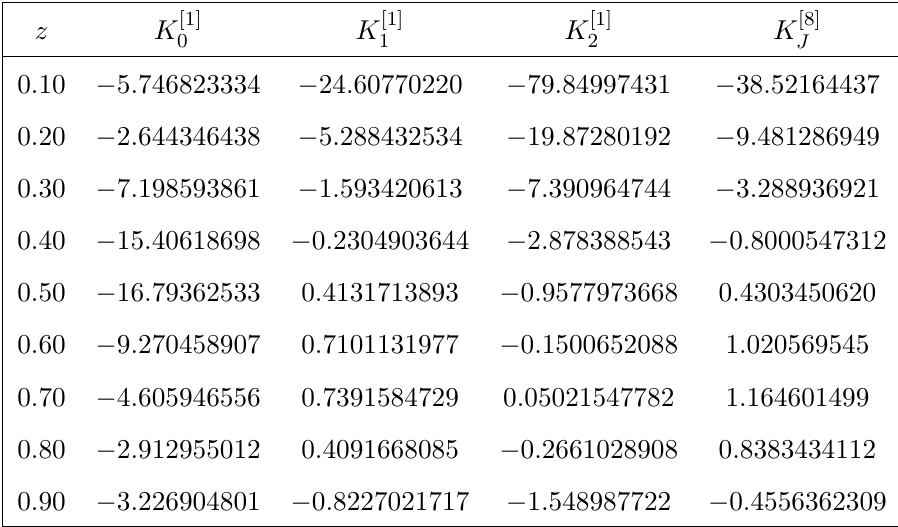
Table 2 . K-factors at different values of z for b ¯ b . K [ c ] and the symbol J means the sum of j = 0 , 1 , 2